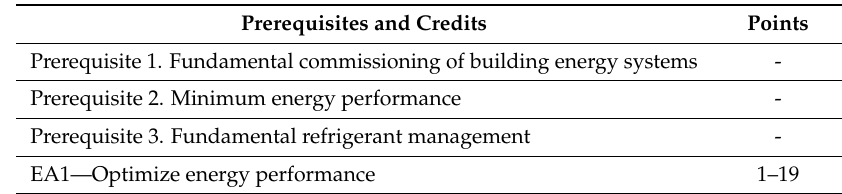
Table 1. Energy and atmosphere credit category of Leadership in Energy and Environmental Design, New Construction (LEED-NC)